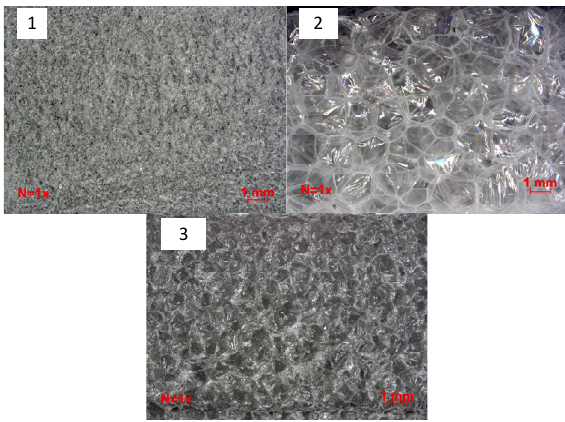
Figure 3. Scanning electron microscope images of the foams of this study, 1) XPE, 2) PE 25 and 3) PE